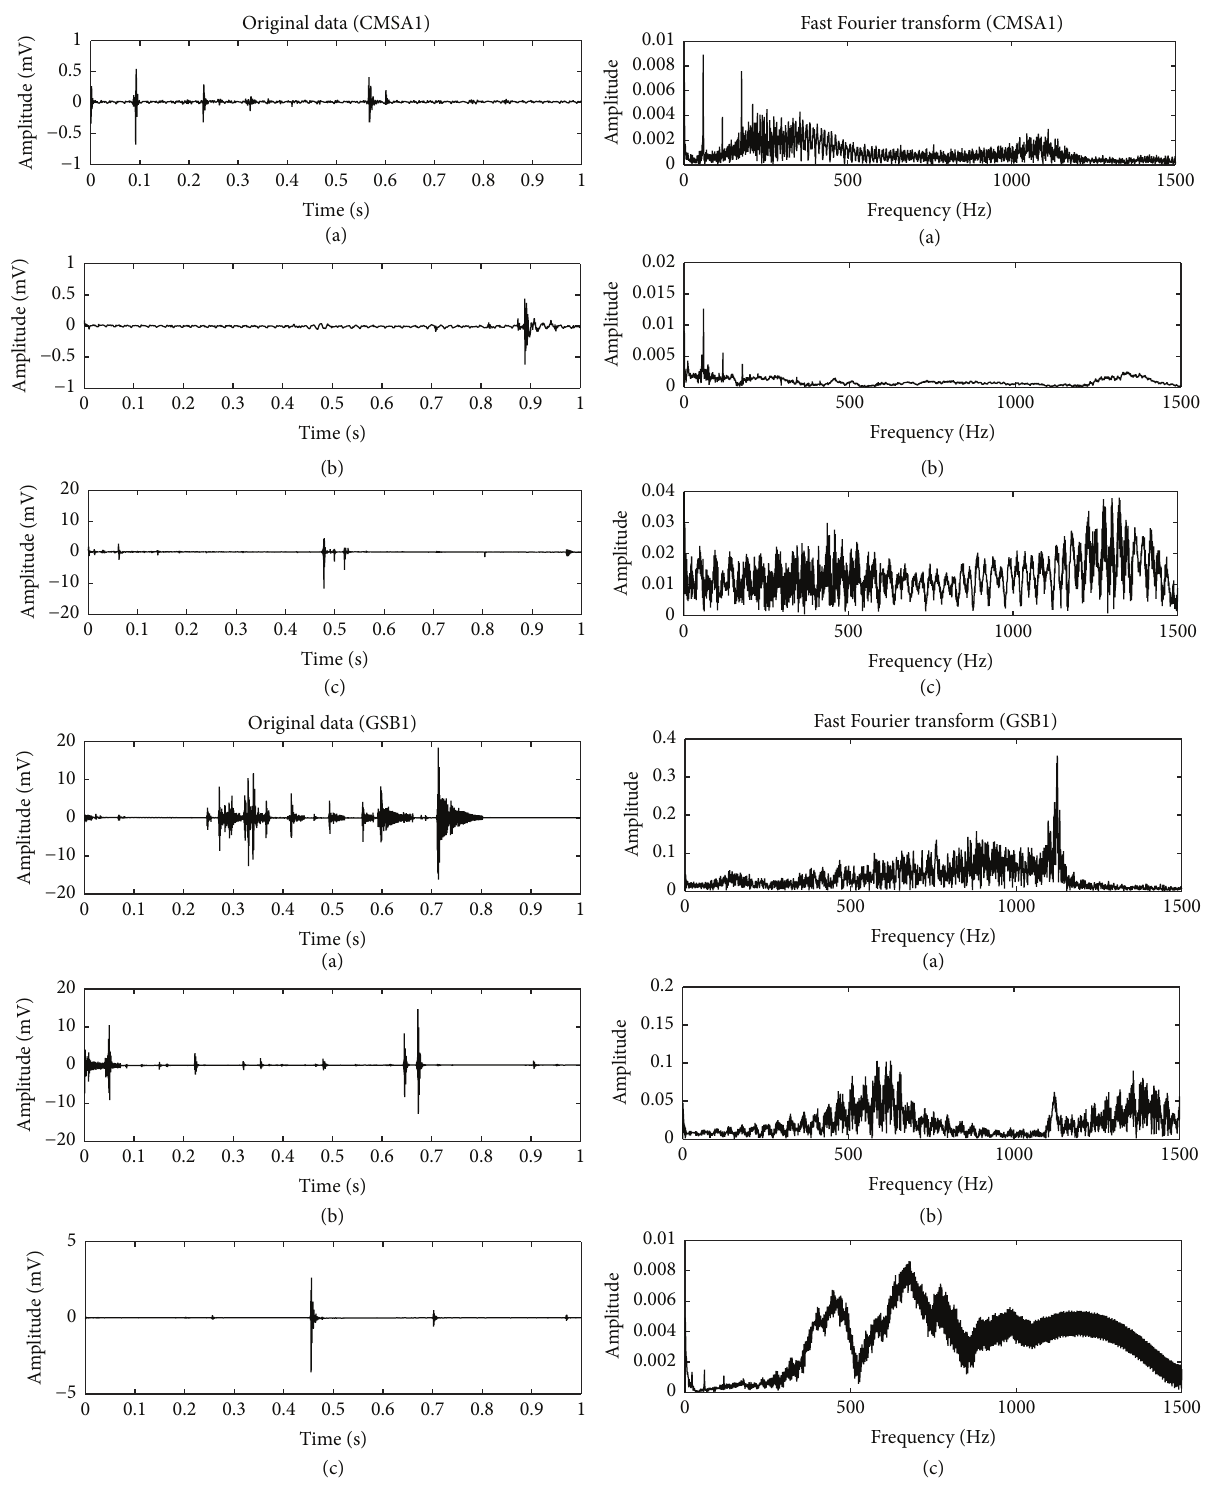
Figure 6: MS signal during cement and glass damage in different loading stages: (a) early stage; (b) middle stage; (c)